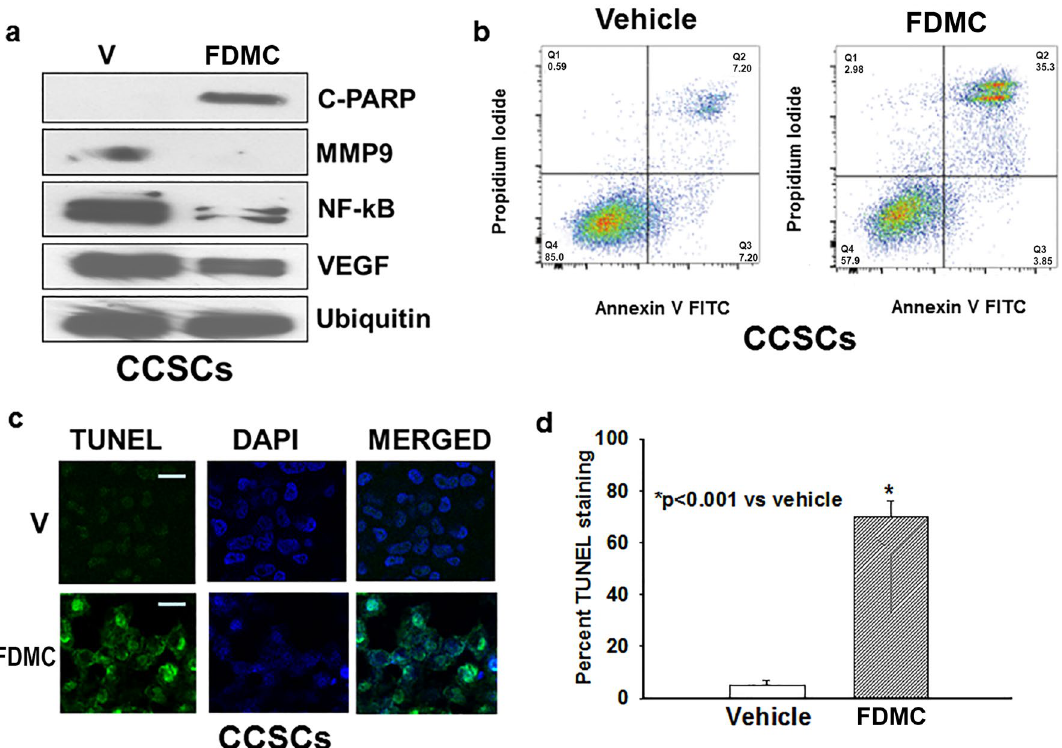
Figure 3. Effect of FDMC on inflammation, angiogenesis, and metastasis markers and induction of apoptosis in CCSCs, as evidenced by comparisons with vehicle-treated controls (V = vehicle). ( a ) Western blot analyses show that FDMC (50 µM) inhibited inflammation (NF-kB expression), angiogenesis (VEGF expression), and metastasis (MMP9 expression) and induced apoptosis (C-PARP) in CCSCs. Data are from 3 independent experiments. ( b ) Flow cytometry analysis of apoptosis (Annexin V/PI) after FDMC and vehicle treatment in CCSCs: FDMC (50 µM) treatment of human CCSCs for 24 h induced 35% apoptosis, whereas 7% apoptosis was seen in the vehicle-treated control. ( c ) Results of immunofluorescence staining (green) TUNEL assay of apoptosis in CCSCs. ( d ) FDMC (50 µM) significantly induced apoptosis in CCSCs (* p < 0.001). Results are mean ± SE (bars; n =